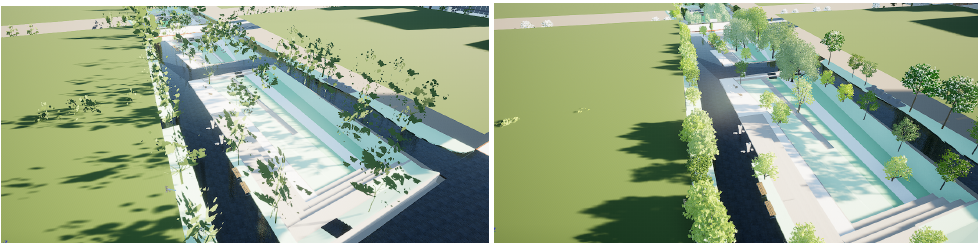
Figure 16. Comparison before and after the vegetation mesh replacement.